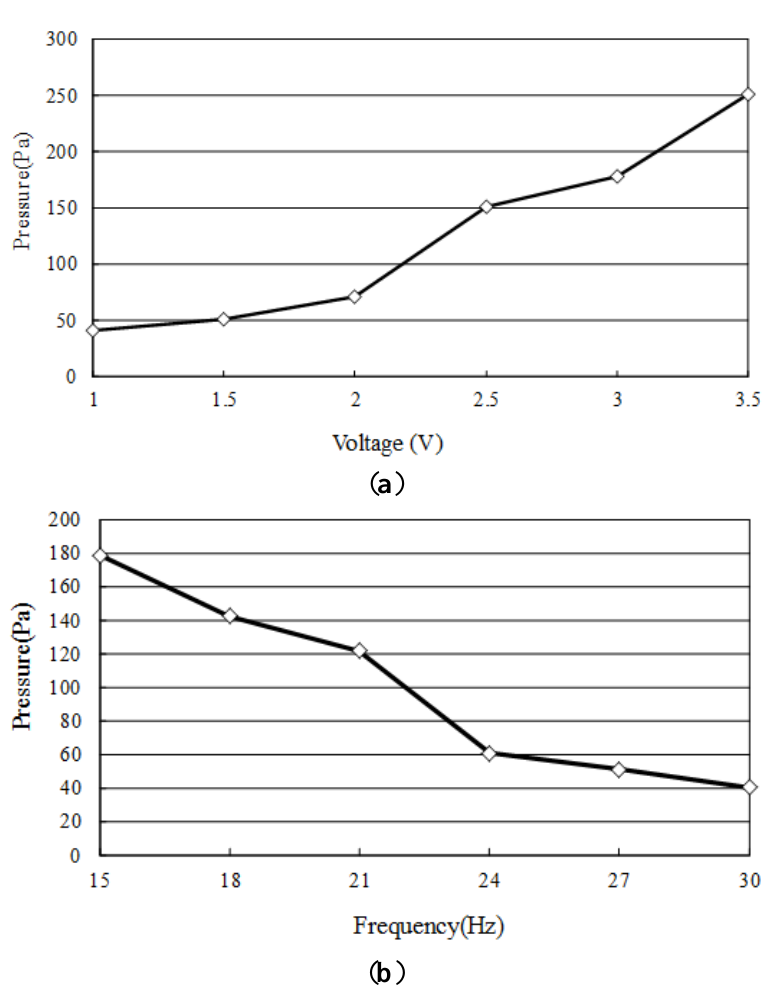
Figure 10. Variation of head pressure given: ( a ) applied voltage ranging from 1~3.5 V and 1 excitation frequency of 15 Hz, and ( b ) excitation frequency ranging from 15~30 Hz and 2 applied voltage of 3.0